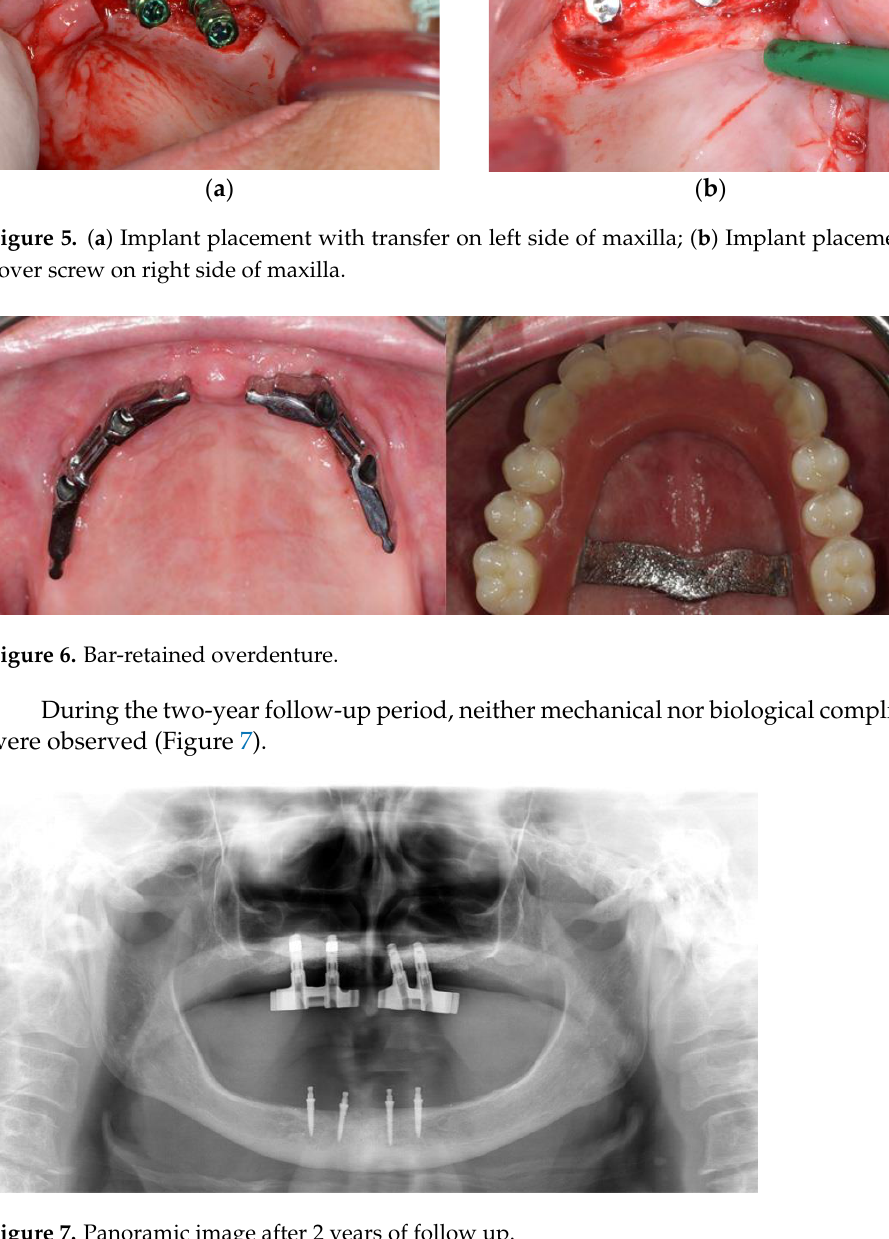
Figure 5. ( a ) Implant placement with transfer on left side of maxilla; ( b ) Implant placement with cover screw on right side of maxilla.